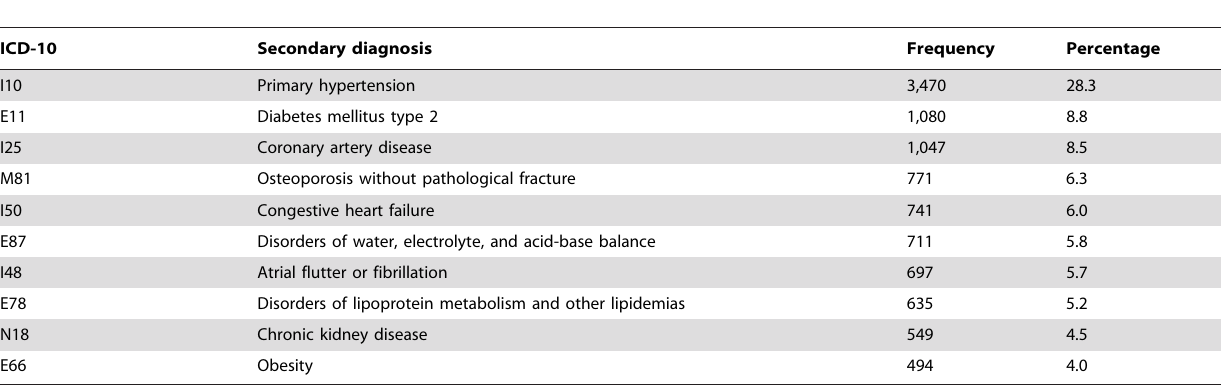
Table 3. Most frequent bronchiectasis-unrelated comorbidities among secondary diagnoses when bronchiectasis is the primary hospital diagnosis